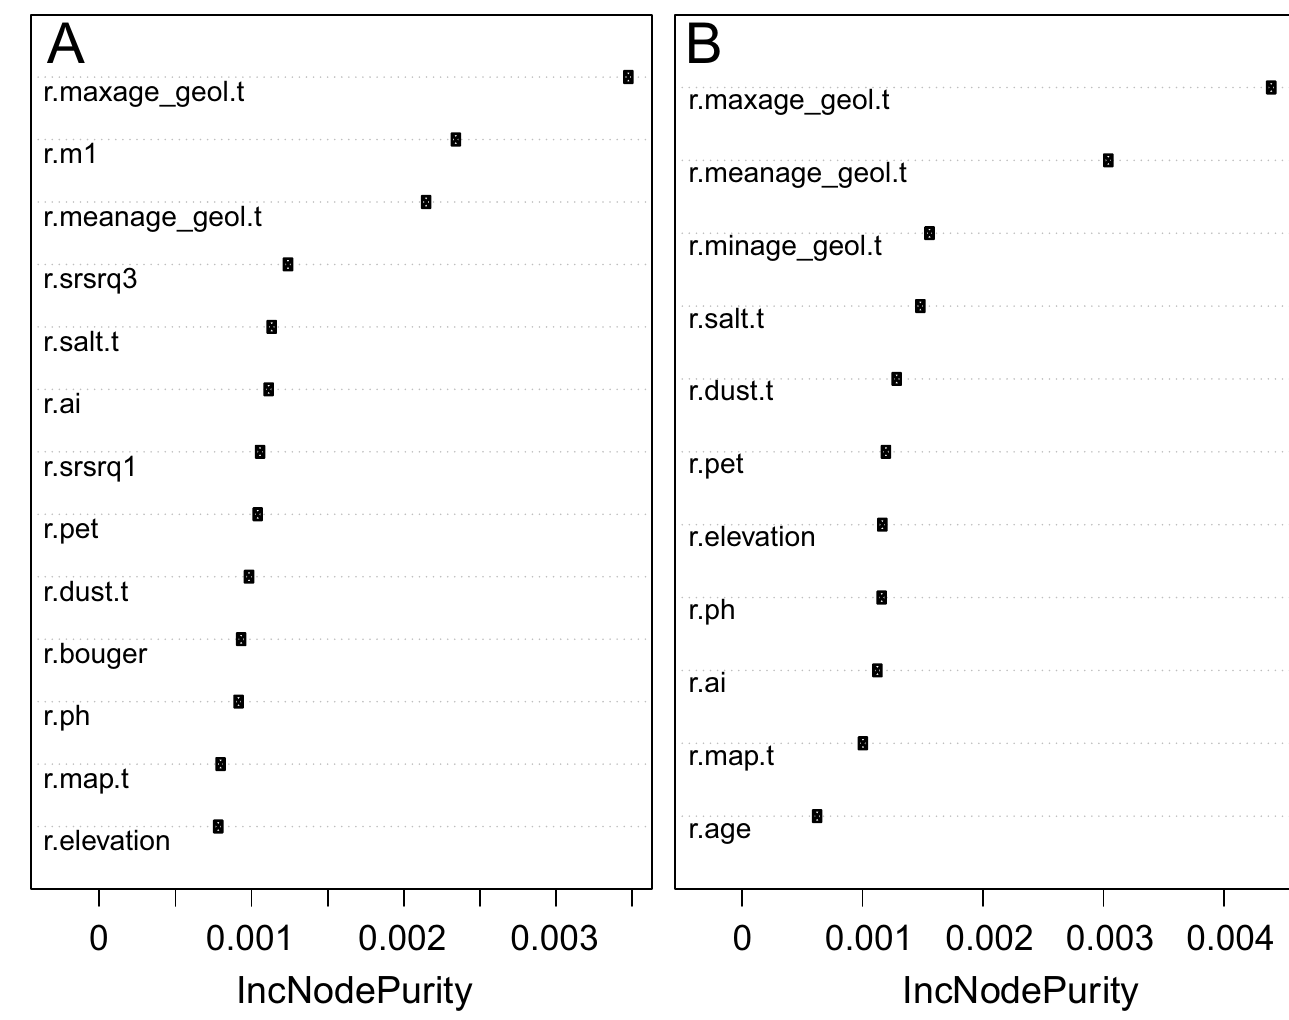
Fig 6. Variable importance plot for the best performing random forest models. A. Variable importance plot for the best performing random forest model (rf model on Fig 3) after selection of variables using the VSURF algorithm; B. Variable importance plot for the random forest regression model without Bataille et al. (2014)’s model products (rf-B14 on Fig 3) after selection of variables using the VSURF algorithm. Refer to Tables 1 and 2 for description of